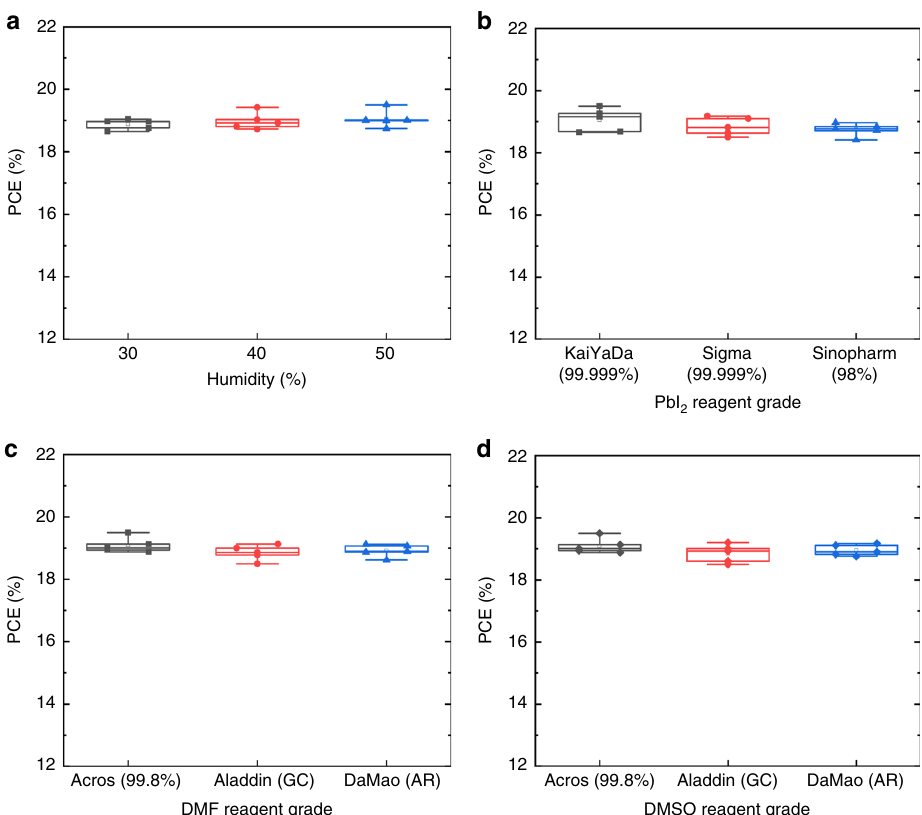
Fig. 5 The ef fi ciency distributions of Prenucleation-PVSCs. Devices fabricated a at different levels of humidity, b using PbI 2 reagents with different grades, c using DMF solvent with different grades and d using DMSO solvent with different grades. All the devices showed very similar standard deviations of PCE with the widely different device fabrication conditions and reagents, demonstrating the reproducibility and robustness of the prenucleation method. In the Box-Whisker Plots, the middle line refers to the median (the second quartile), the box goes from the fi rst quartile to the third quartile, the upper/lower whisker refers to the maximum/minimum values of the data